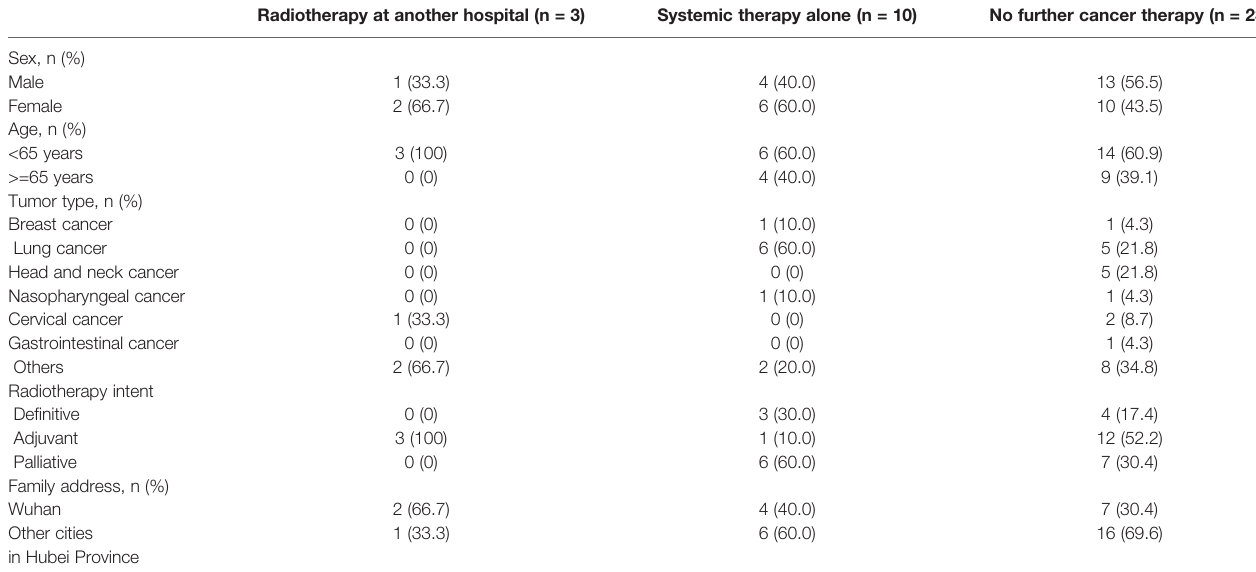
TABLE 2 | The characteristics of patients who did not come back for